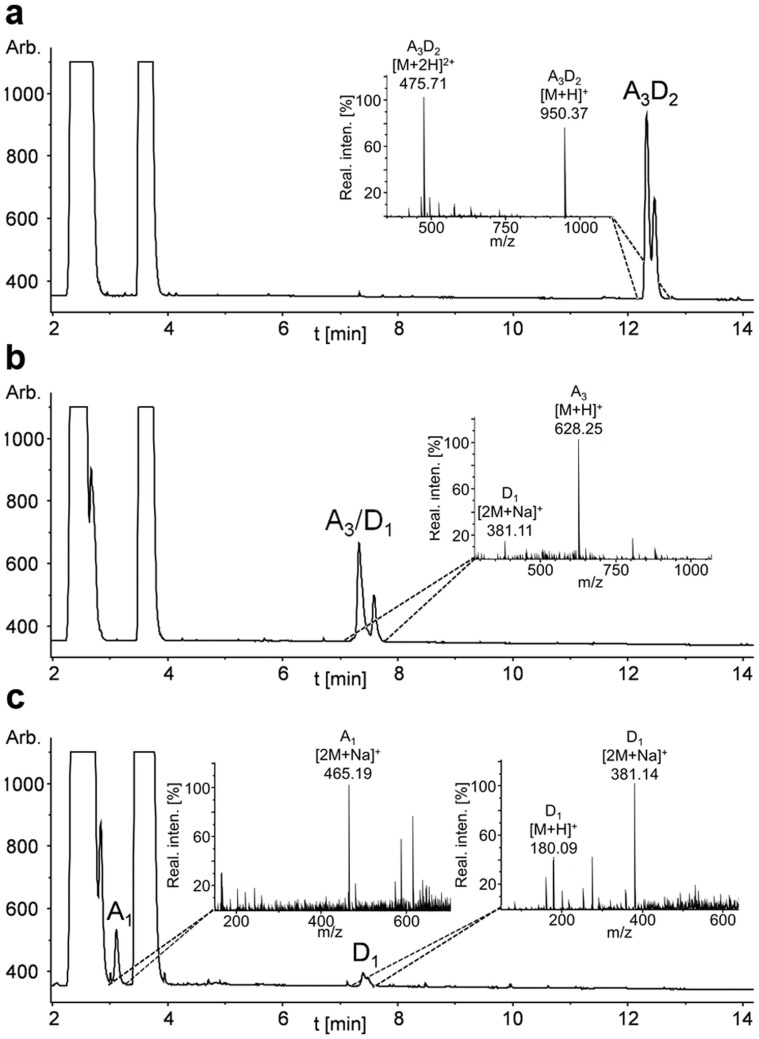
Enzymatic sequencing in combination with UHPLC-ELSD-ESI-MS analysis of double-deacetylated chitosan pentamer (a3d2).The product a3d2 was obtained after the incubation of GlcNAc5 (a5) with NodB and COD (a). To determine the PA, it was first hydrolysed with the GlcNase GlmATK, which removes exclusively GlcN units from the non-reducing end. The reaction resulted in GlcN1 (d1) and GlcNAc3 (a3) (b). In the next step, GlmATK was replaced by the GlcNAcase BsNagZ, which exclusively removes GlcNAc units from the non-reducing end, resulting in GlcN and GlcNAc monomers (c).The enzymatic sequencing of the simultaneous hydrolysis product of NodB and COD revealed that the first two units starting from the non-reducing end were deacetylated, giving a specific chitosan oligomer with the novel PA ddaaa.